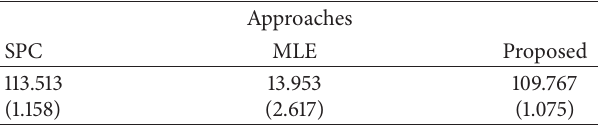
Table 2: Performance comparisons among two approaches in the case of an unknown negative binomial process without MLE.